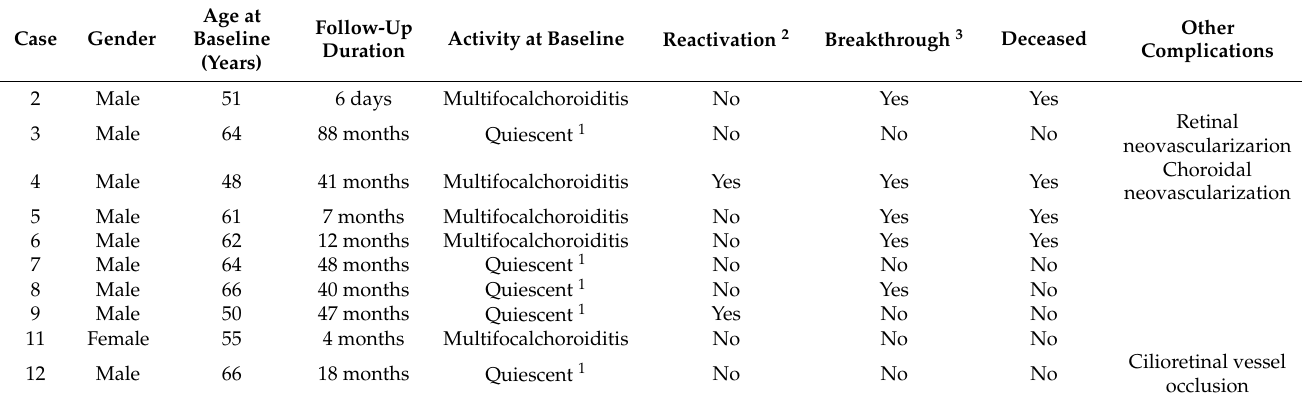
Table 1. Patient characteristics at baseline and during the observation period.